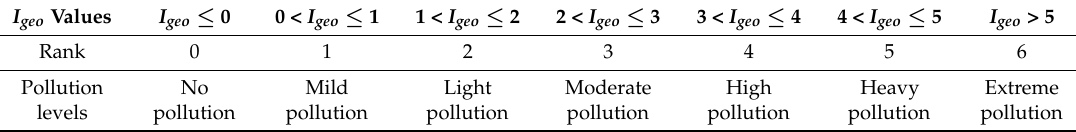
Table 5. Contamination rank corresponding to geo-accumulation